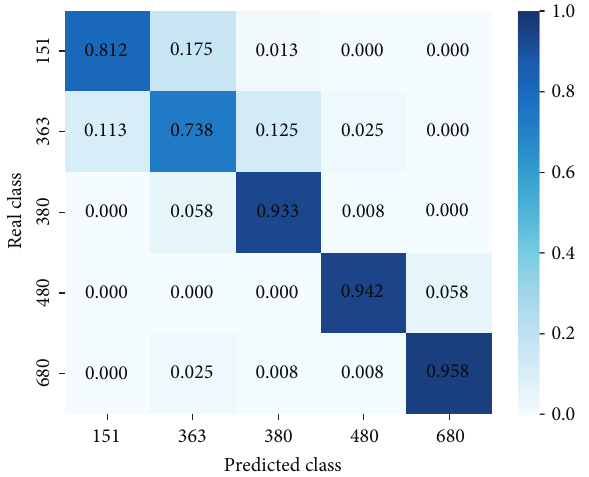
Figure 7: Mean confusion matrix for the best performing CNN for scenario B.